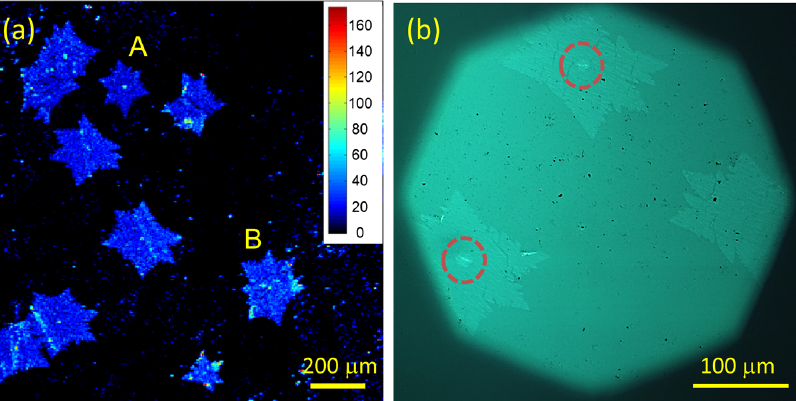
FIG. 4. (a) THG p -in/ p -out scan of a 1 : 4 (cid:9) 1 : 4 mm 2 area featuring star-shaped CVD-grown monolayer graphene crystals on glass, which are approximately 200 (cid:2) m in characteristic dimension. (b) Optical microscopy of graphene stars on glass. The central bright spots (inside the dashed red circles) correspond to bilayer